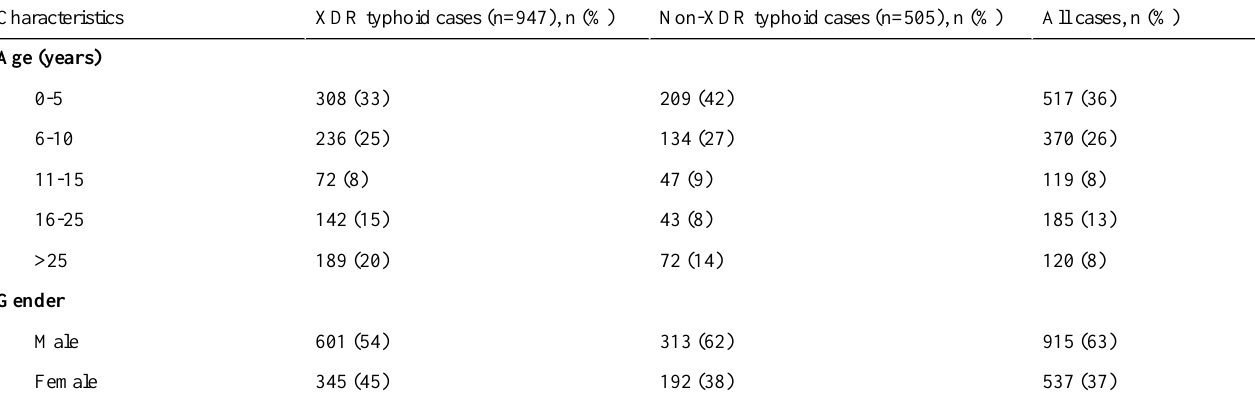
Table 1. Age and gender distribution of hospitalized patients with XDR a typhoid and those with non-XDR typhoid in Hyderabad, Pakistan, from October 1, 2016, to September 30, 2018 (N=1452).